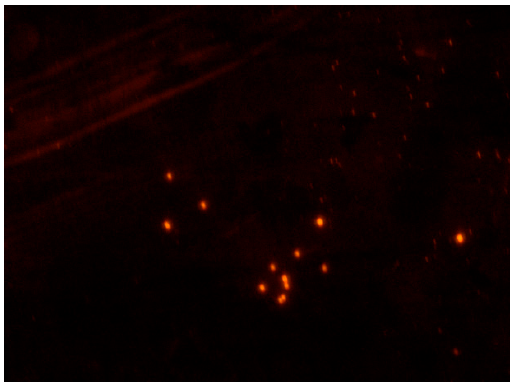
Figure 3. Fluorescence microscopy image (magnification 40x) of SUT imprinted particles grafted with Rhodamine 6G (R6G).